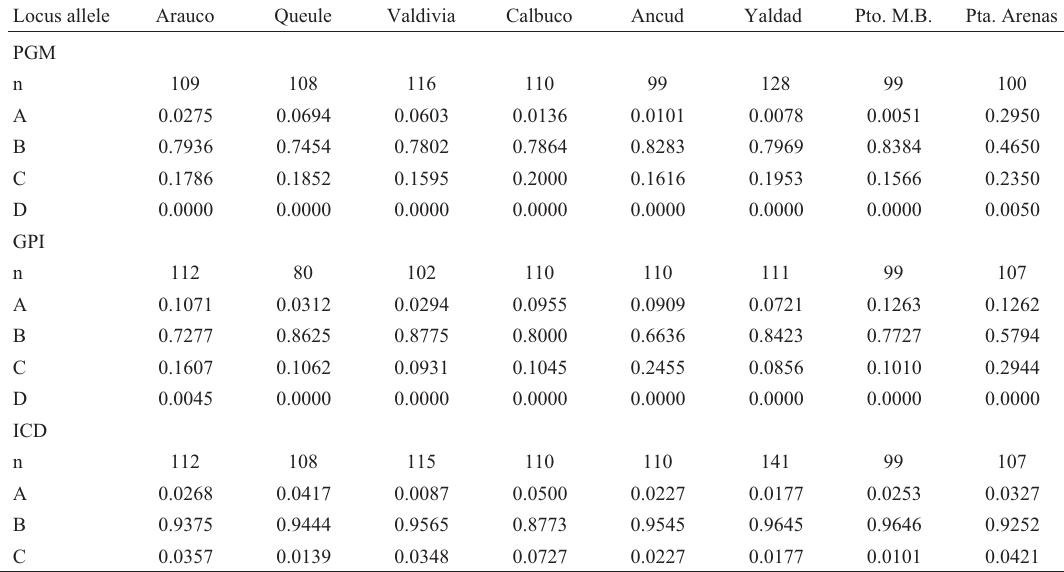
Table 1 - Allele frequencies for the seven polymorphic loci screened in eight populations of the chilean blue mussel ( Mytilus chilensis ). Locus